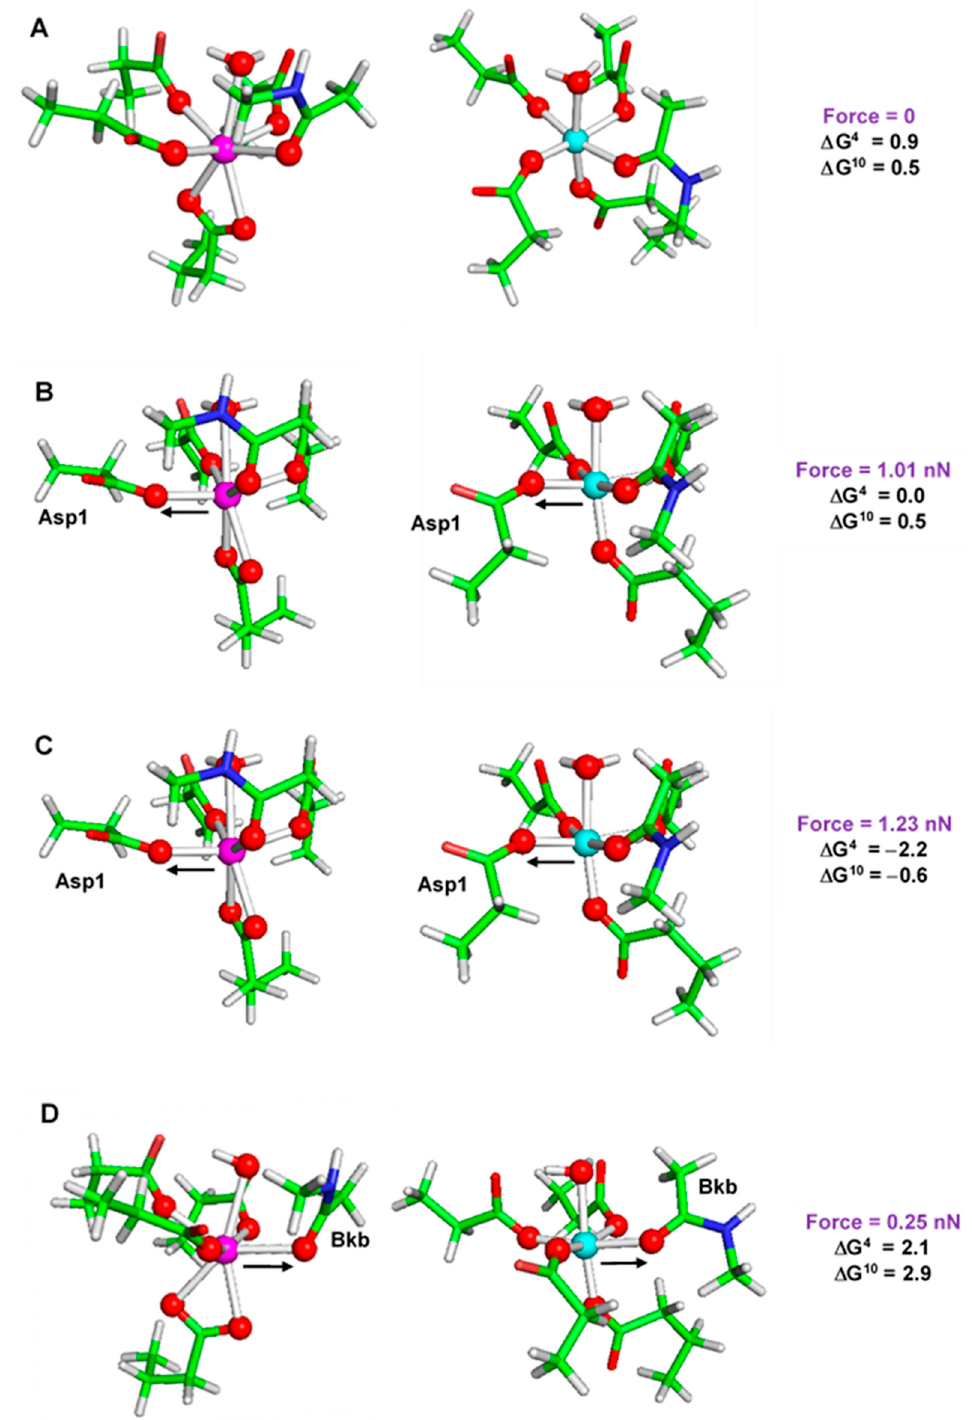
Figure 9. Free energies of Ca 2+ → Mg 2+ exchange (in kcal/mol) in metal complexes with external force of ( A ) 0 nN, ( B ) 1.01 nN applied along the M-Asp1 bond, ( C ) 1.23 nN applied along the M-Asp1 bond, and ( D ) 0.25 nN applied along the M-Bib bond. Positive ∆ G 4 / ∆ G 10 (for buried and partially buried binding sites, respectively) imply a calcium-selective binding site, whereas negative free energies signifies a magnesium-selective one. Abbreviations: nN = nano-Newton, Asp = aspartate, and Bkb = backbone peptide group. Col-or scheme—C: green, O: red, N: blue, H: light grey, Ca: magenta, Mg: cyan. Reprinted from Ref. [81]. Copyright 2020 Royal Society of